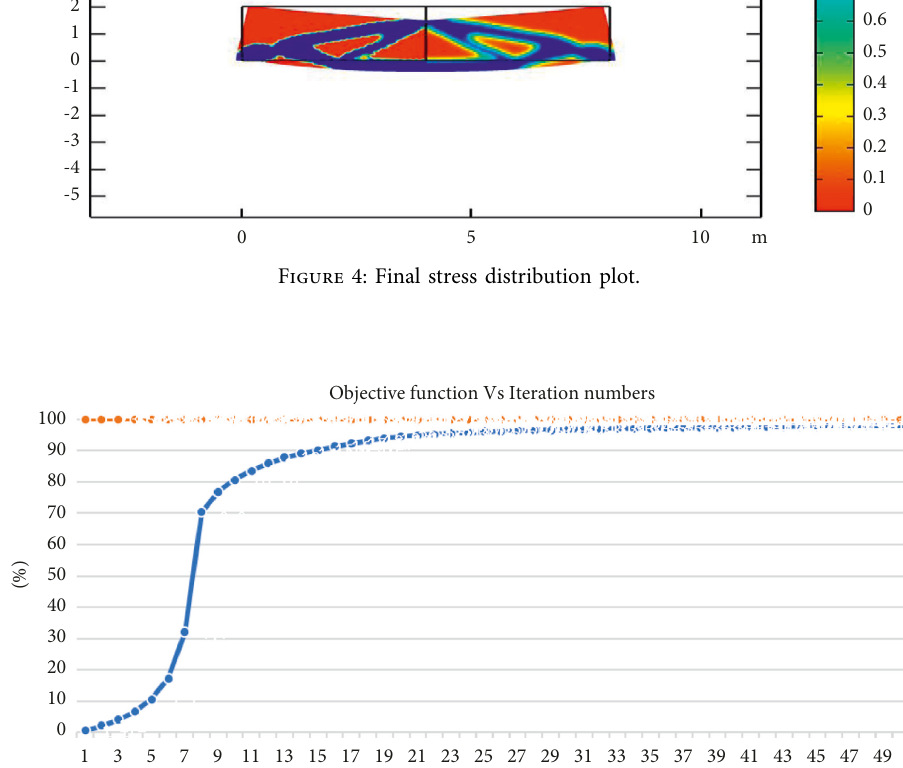
Figure 5: Volume reduction vs